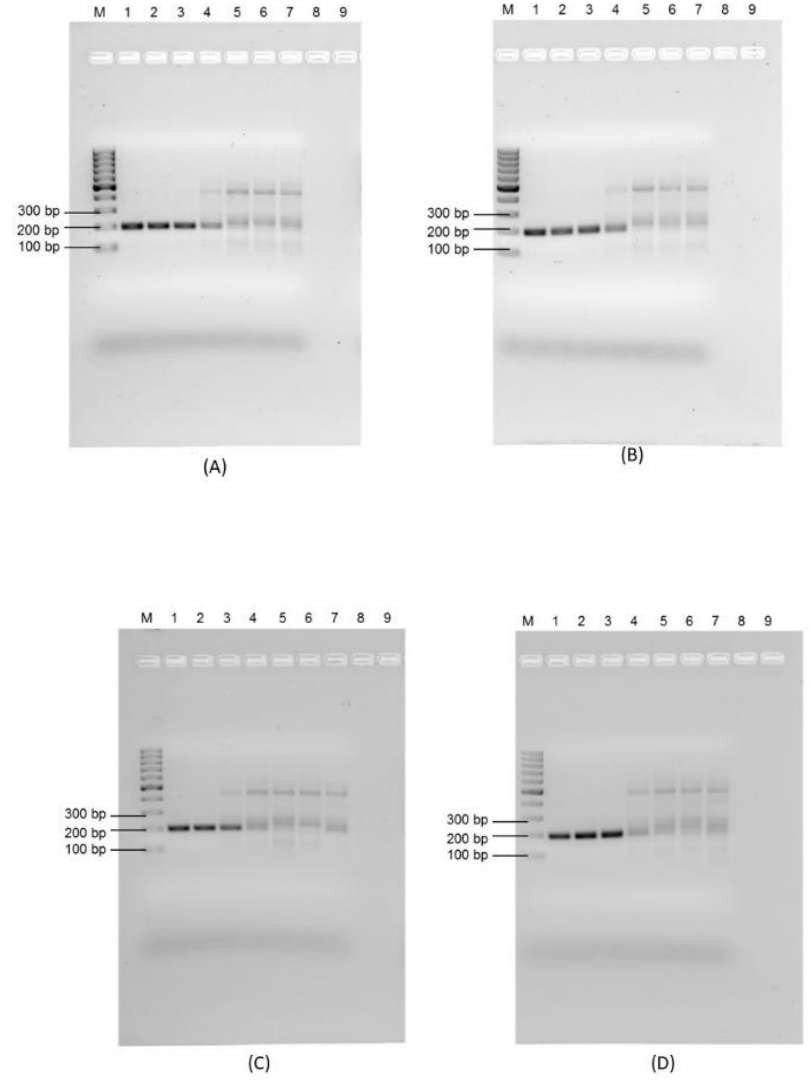
Figure 4. Sensitivity of RPA assay for detection of E. faecalis using ( A ) tap water; ( B ) Koo Wee Rup wastewater; ( C ) Lang Lang wastewater; ( D ) saline. Well M: molecular marker; Wells 1 to 7: 2.8 × 10 6 CFU/100 mL, 2.8 × 10 5 CFU/100 mL, 2.8 × 10 4 CFU/100 mL, 2.8 × 10 3 CFU/100 mL, 2.8 × 10 2 CFU/100 mL, 2.8 × 10 1 CFU/100 mL, 2.8 CFU/100 mL.